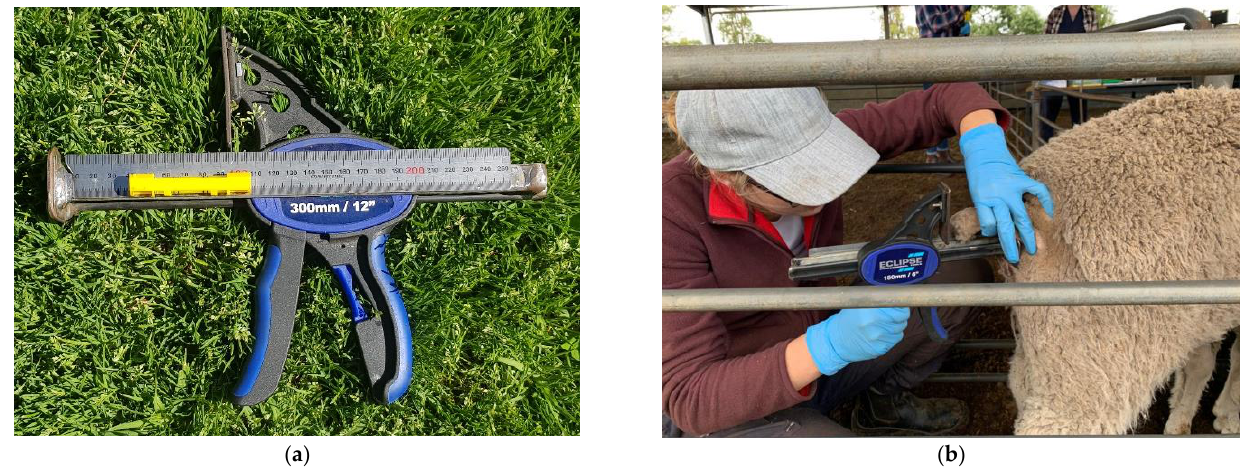
Figure 1. ( a ) The device created and used for the length measurement of tails. ( b ) The device in use on a weaner ewe.